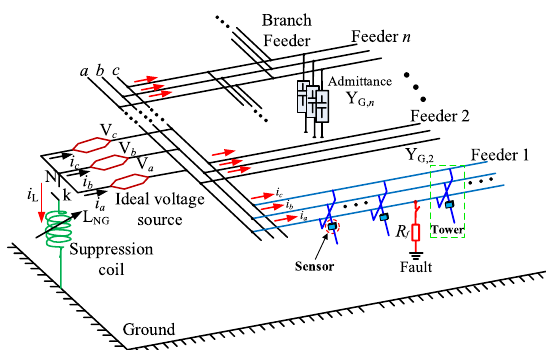
Fig. 1 Grounding fault model of distribution network